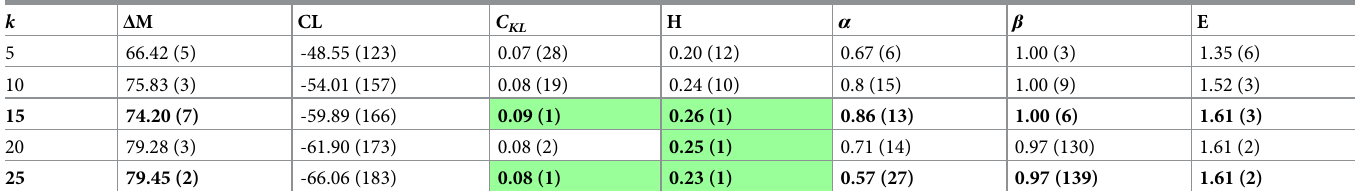
Table 10. Effects of k parameter. The effects of varying scaling factor k on detecting structural variation signals from pseudopaper Ps ( S 3,1 � S 3,2 ) are demonstrated for Case 3. The numbers in parentheses indicate to the pseudopaper’s ranks by the corresponding metrics. k Δ M CL C KL H α